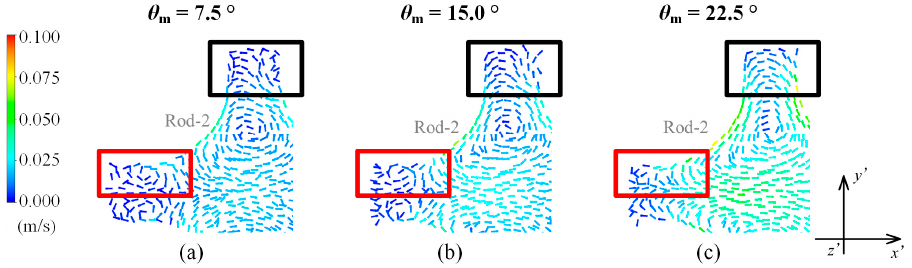
Figure 10. Transverse flow field with different amplitudes ( t = 0). ( a ) θ m = 7.5 ◦ ; ( b ) θ m = 15.0 ◦ ; ( c ) θ m = 22.5 ◦